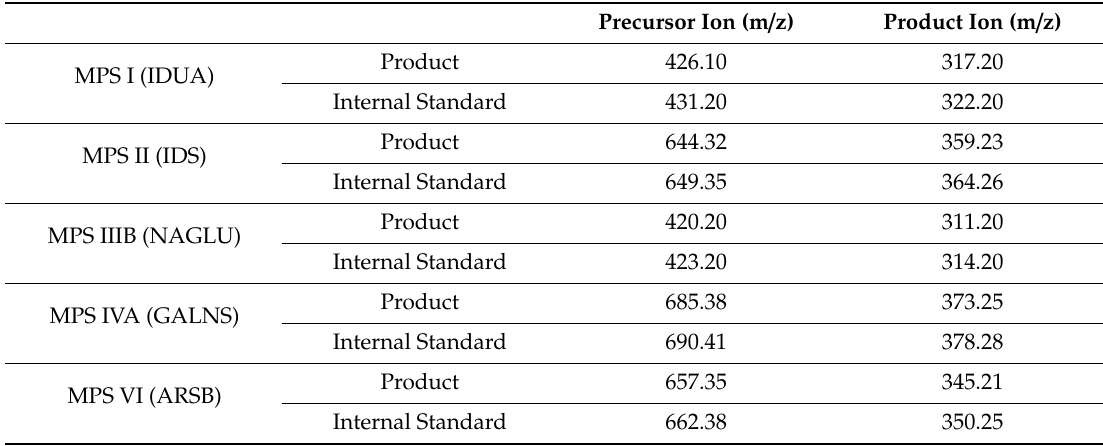
Table 4. Precursor ion and product ion of the reaction product and internal standard in each disease